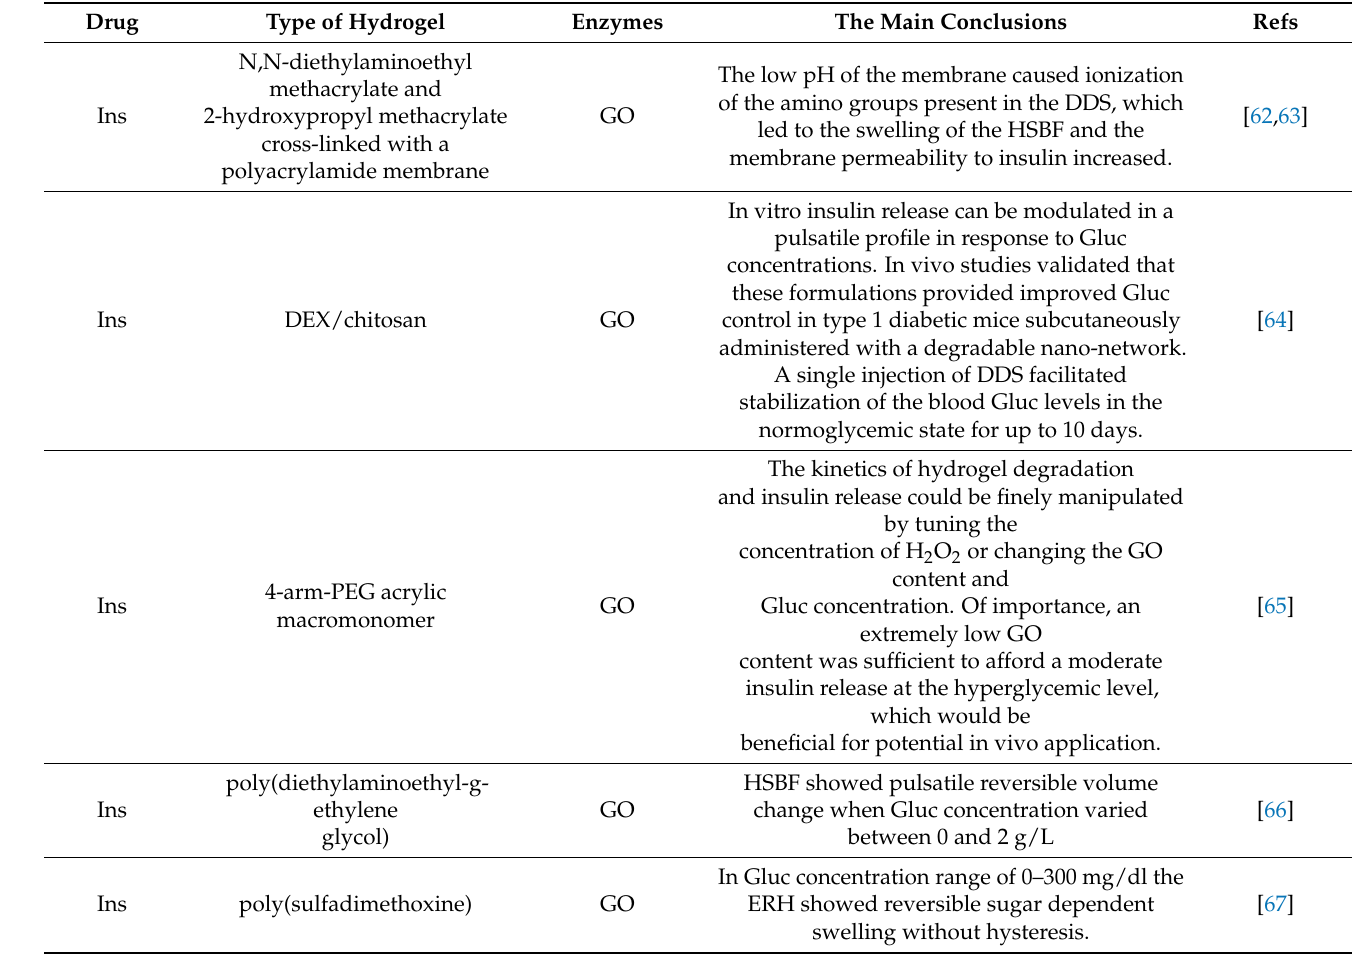
Table 3. Hydrogel drug delivery systems activated by